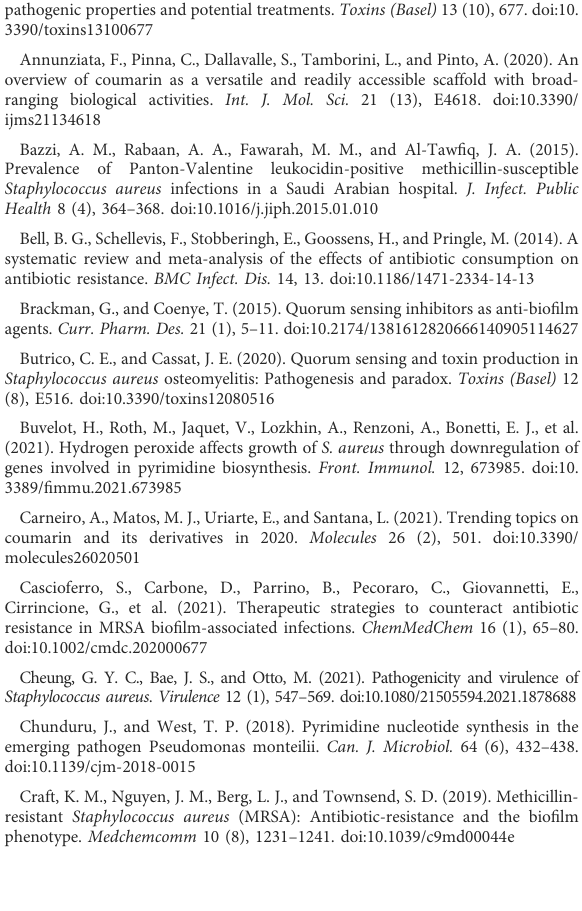
ChemicalStructureofLP4CandhomologymodelingofPyrRprotein.The chemical structure of pyrancoumarin cderivative LP4C (A) . The homology modeling S. aureus structure of PyrR protein, the part of the model with low credibility of the Quaternary Structure was shown in orange, and the credibility near the active site was shown in blue (B) . Most of the predicted local similarity to target shown by Local Quality Estimate is greater than 0.6, and the GMQE was 0.81 (C) . Consensus- based distance constraint (DisCo) score was 0.77 ±0.05, and the credibility was more than 95% (D)